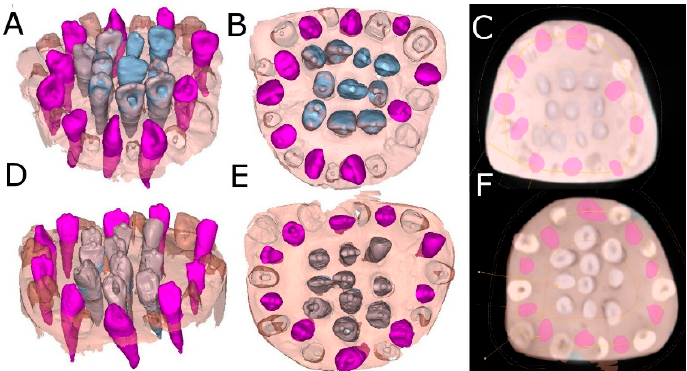
Figure 3. ( A ) Frontal, ( B ) occlusal and ( C ) apical view of the individually segmented (blue) and autotransplanted teeth (purple) between the teeth placed outside of the experimental model (pink) randomly assigned to the SNT study group. ( D ) Frontal, ( E ) occlusal and ( F ) apical view of the individually segmented (grey) and autotransplanted teeth (purple) between the teeth placed outside of the experimental model (pink) randomly assigned to the FT study